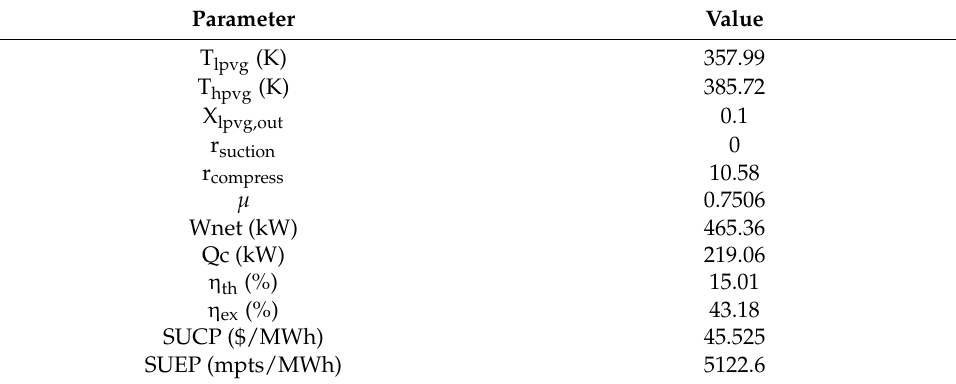
Table 10. The optimal condition calculated based on genetic